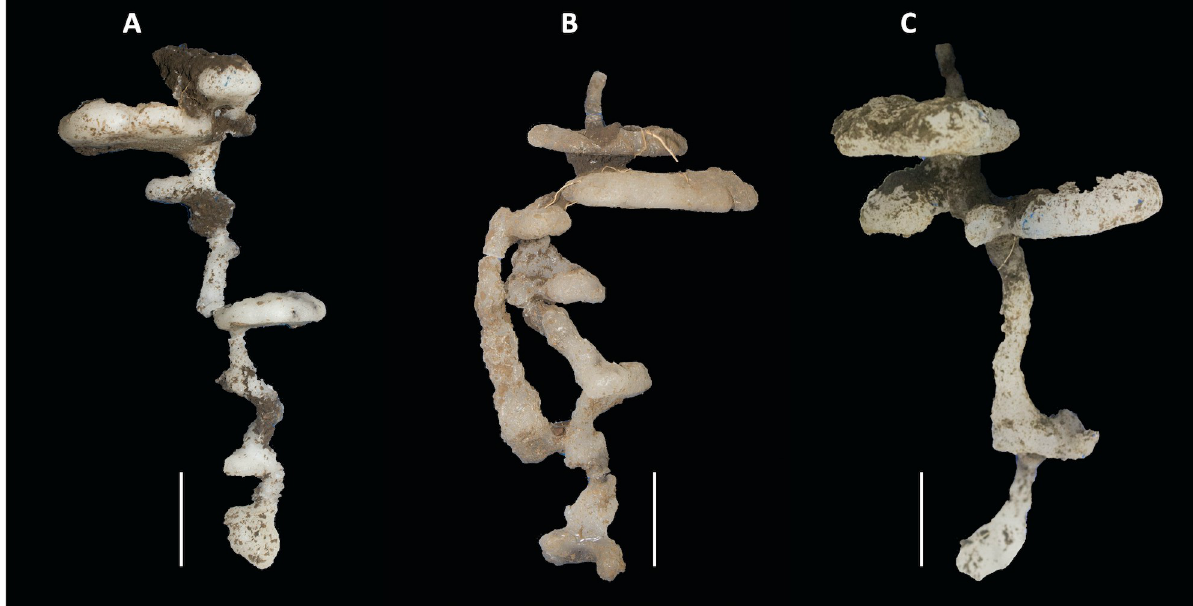
Fig 2. Examples of nests of Ectatomma ruidum sp. 2 of similar depth, cast in paraffin wax. (A) nest #3 (depth: 28 cm), (B) nest #6 (depth: 27 cm), (C) nest #22 (depth: 29 cm) (see S1 Table for detailed nest features). The scale bars correspond to 5 cm. Photos: C.